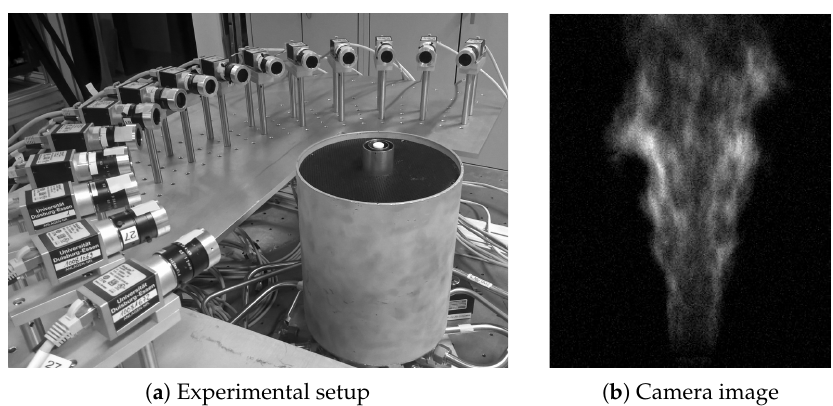
Figure 12. Experimental setup and flame image (Cambridge–Sandia stratified flame).